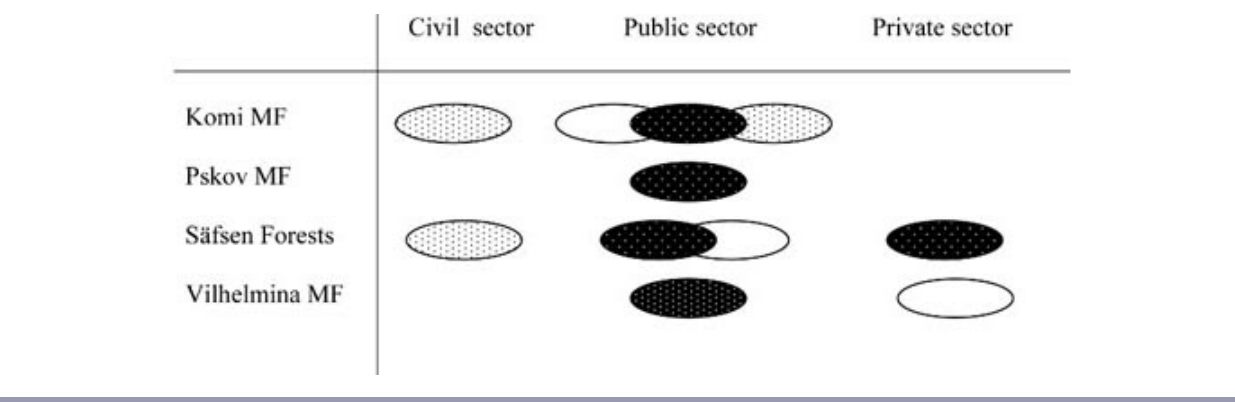
Fig. 5. The most represented sectors (the horizontal dimension of a governance system) of the Group 1, Group 2, and Group 3 stakeholders in Russian and Swedish MF initiatives. A circle with white dots on a black background indicates a Group 1 stakeholder, a circle with black dots on a white background indicates a Group 2 stakeholder, and an empty circle indicates a Group 3